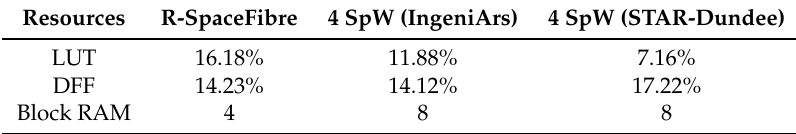
Table 4. R-SpaceFibre and four SpaceWire interfaces resources utilisation on